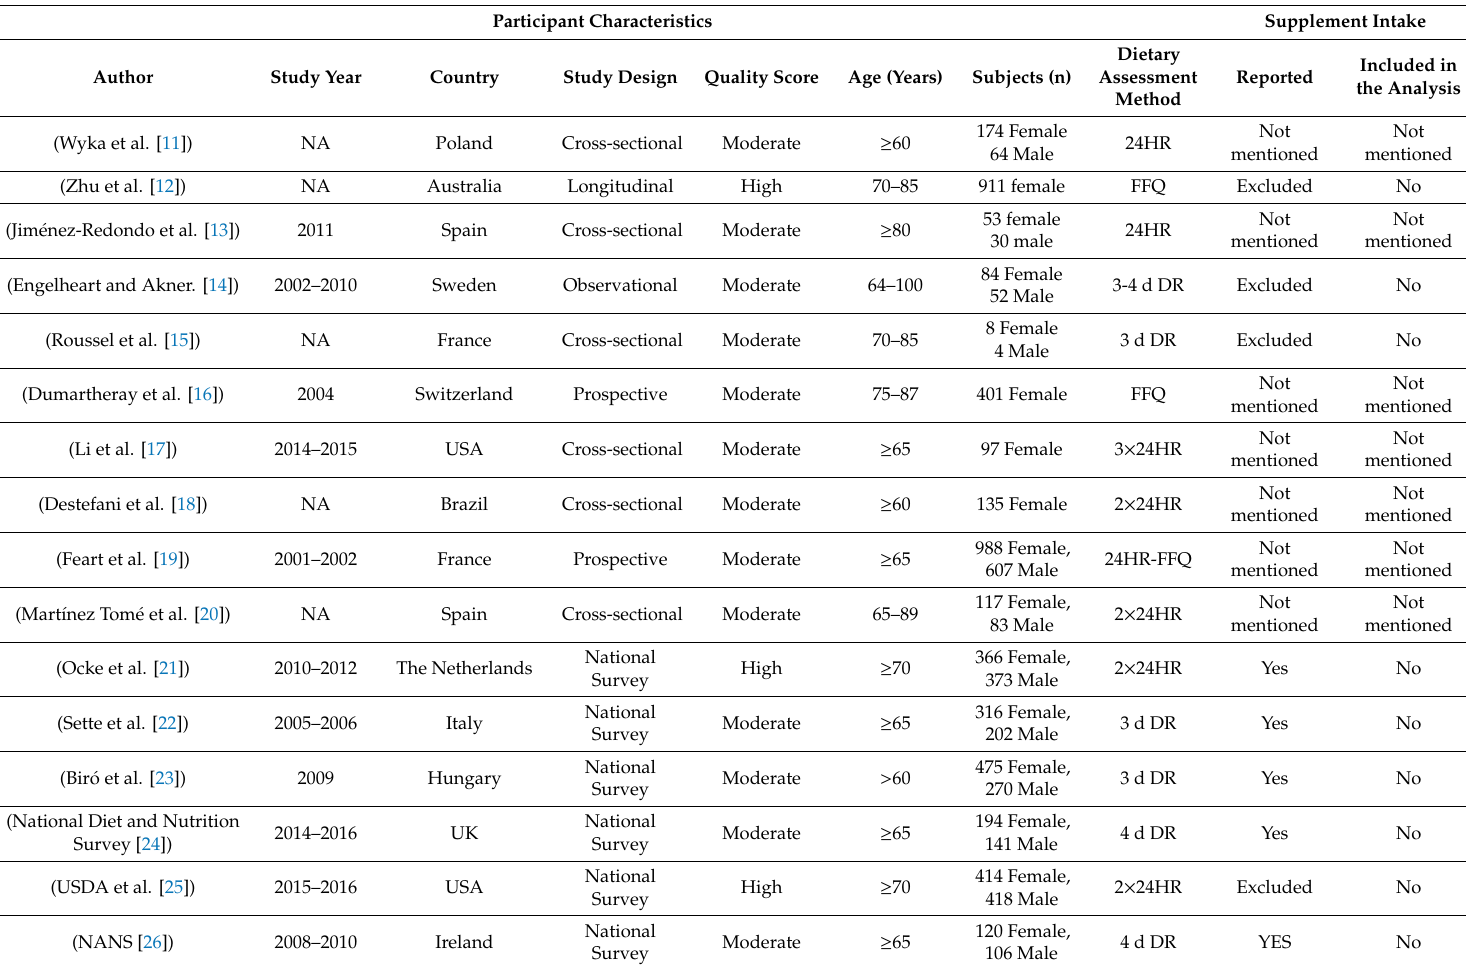
Table 2. Summary of the included studies, evaluating trace mineral intake in older adults living in the